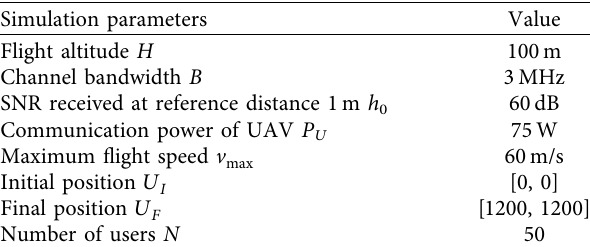
Table 1: Simulation parameter setting.